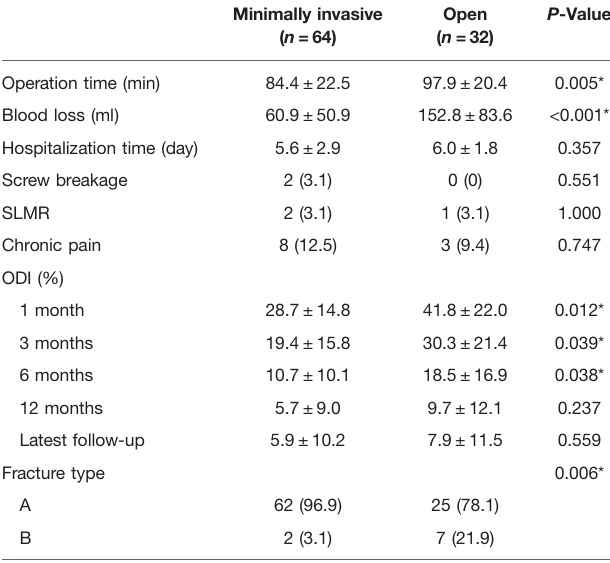
TABLE 5 | Comparison of two surgical approaches at the latest follow-up. Minimally invasive ( n